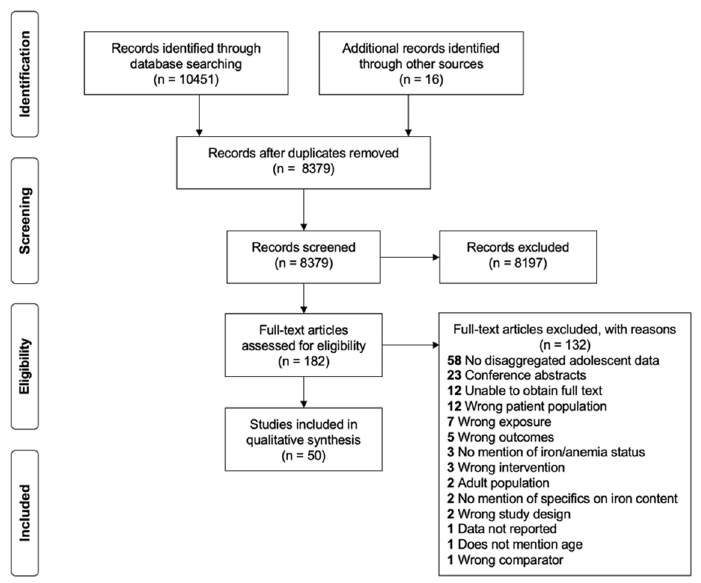
Figure 1. PRISMA flow diagram of study selection.